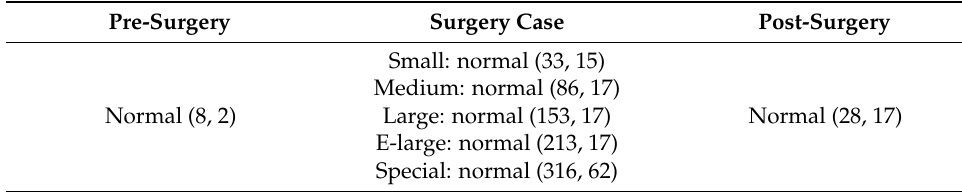
Table 3. The durations (minutes) of pre-surgery, surgery, and post-surgery.